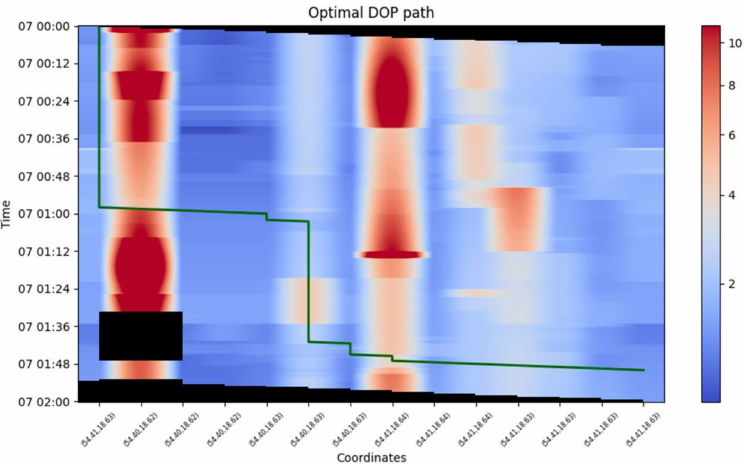
Figure 13. Diagram of the optimal 2D route during the second measurement campaign